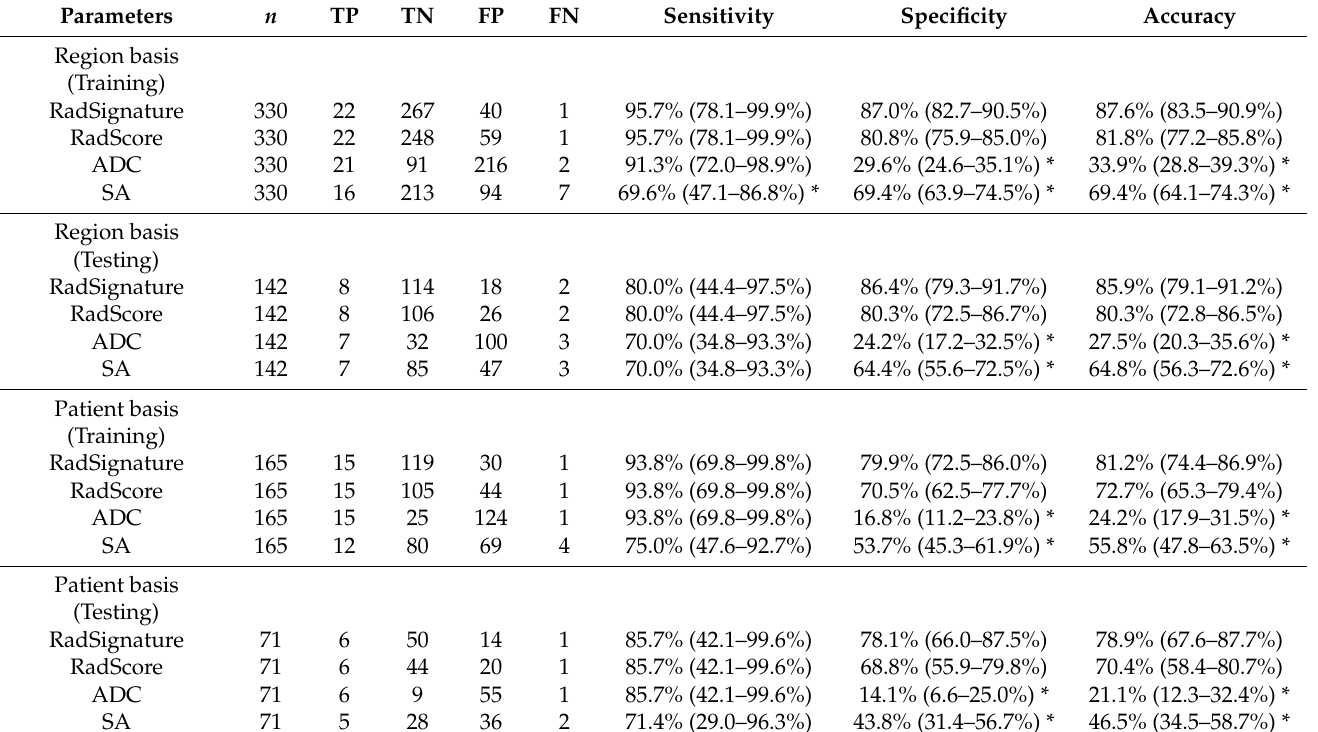
Table 3. Diagnostic accuracy for detecting pelvic lymph node metastasis based on selected magnetic resonance (MR) imaging features.